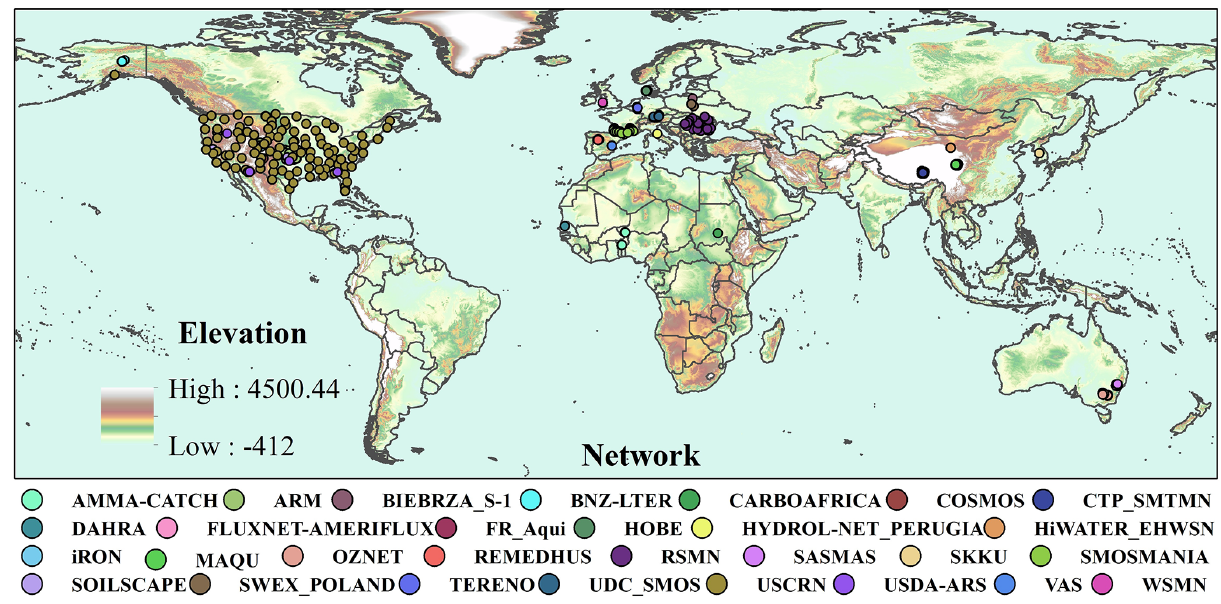
Figure 3. Global distribution of the networks and stations in the ISMN